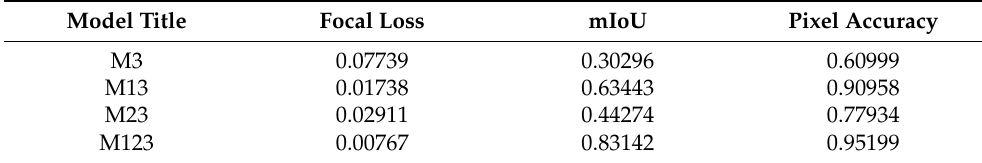
Table 3. Focal loss, mIoU, and pixel accuracy values for the fine ‐ tuning validation set after the train ‐ ing.